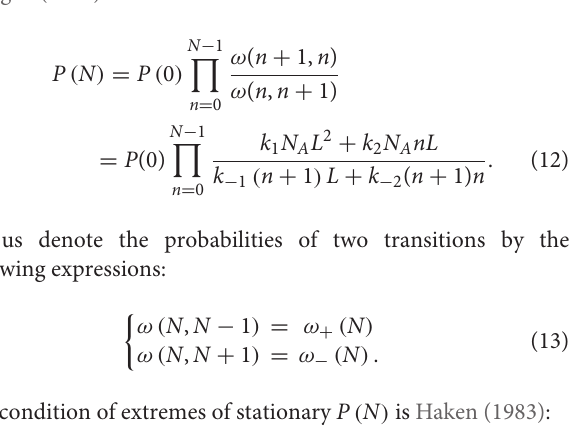
Dividing Equation (18) by Equation (19) and